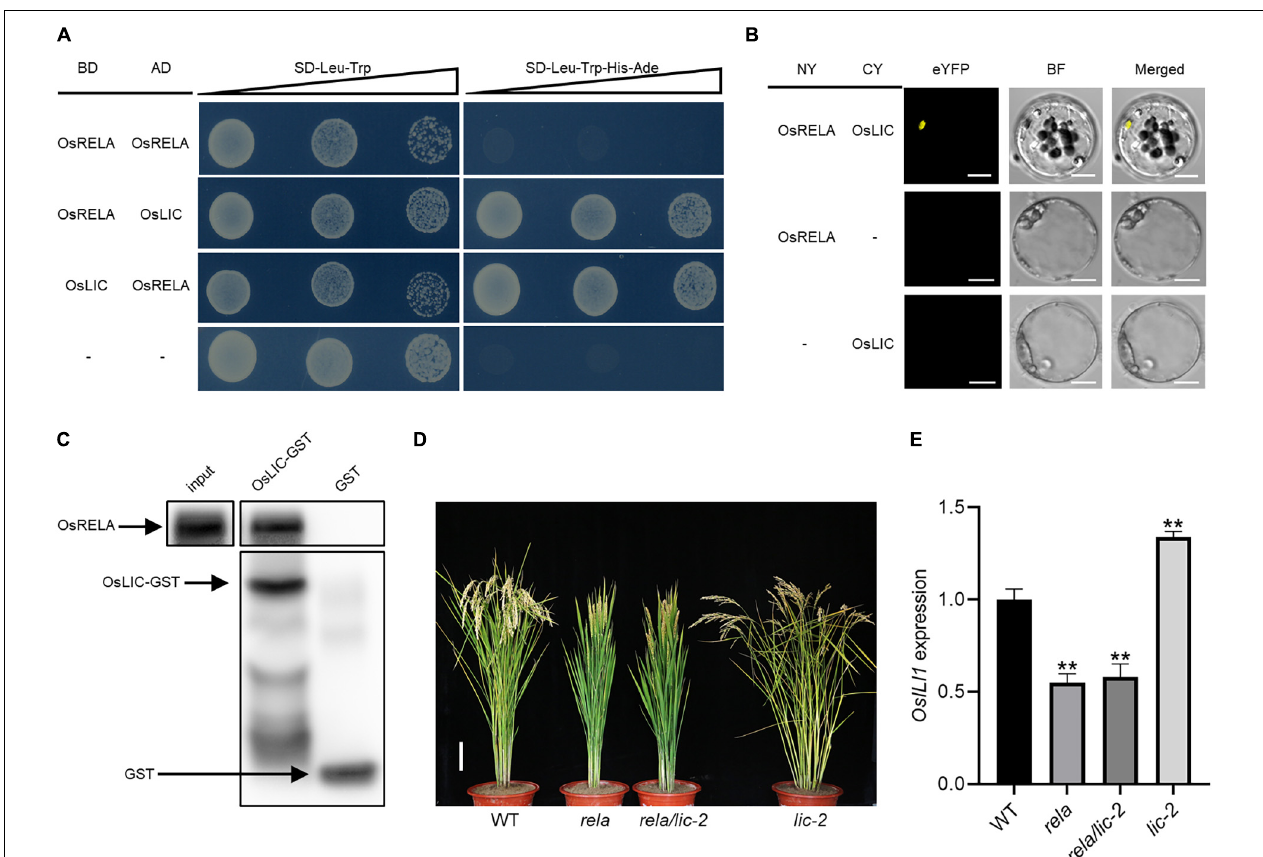
FIGURE 5 | OsRELA physically interacts with and acts downstream of OsLIC. (A) Interactions between OsRELA and OsLIC in yeast two-hybrid assays. OsRELA could not form homodimer in yeast. AD, activation domain; BD, binding domain; SD, synthetic dropout; the gradients indicate tenfold serial dilutions. (B) BiFC analysis of OsRELA and OsLIC interactions in rice protoplasts. BF, brightfield. Scale bars, 5 µ m. (C) LIC-GST proteins can pull down OsRELA from total protein extracts of 1-week-old wild-type plants. OsRELA was detected by immunoblotting using anti-OsRELA-specific polyclonal antibodies. (D) Plant morphologies of wild-type, rela, rela/lic-2 and lic-2 at the heading stage. Bar = 10 cm. (E) RT–qPCR analysis of OsILI1 expression levels in wild-type, rela, rela/lic-2 and lic-2 lamina joints. The rice UBQ gene was amplified as the internal control. Asterisks indicate significant differences from the WT (** P < 0.01, Student’s t